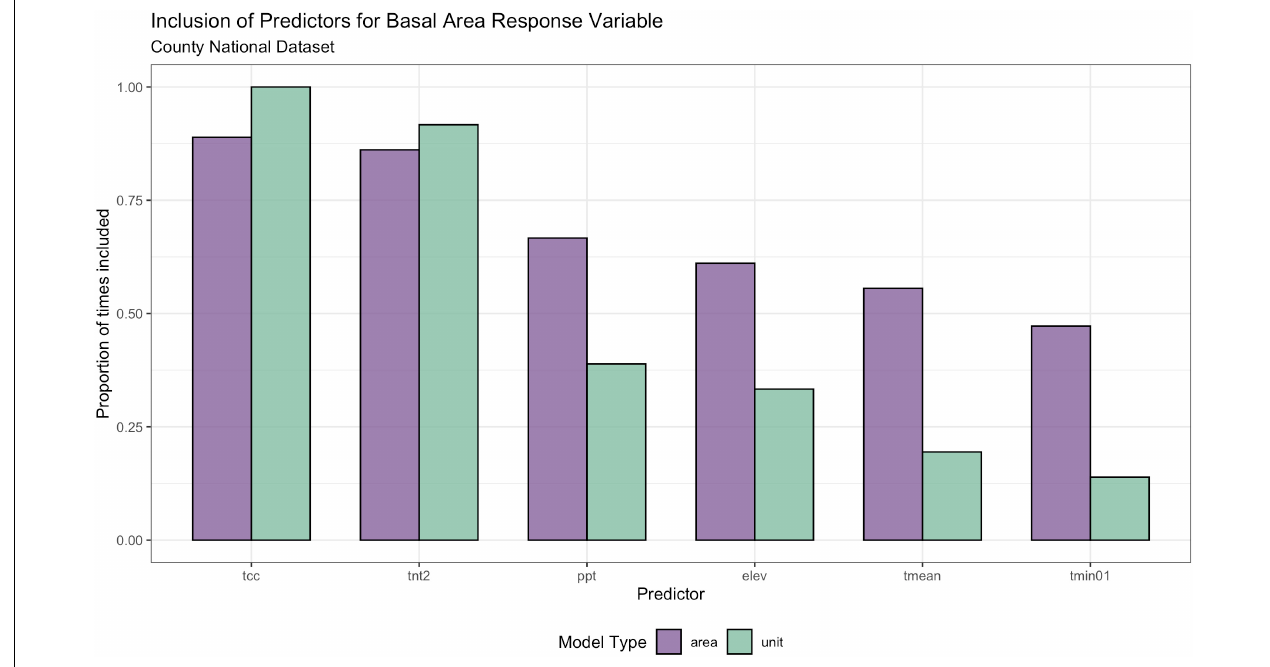
FIGURE 5 | Proportion of times each of the predictor variables was selected for area-level (purple) and unit-level (green) model-based estimators (both EBLUP and HB) applied to the county national dataset through the elastic net variable selection process used in this